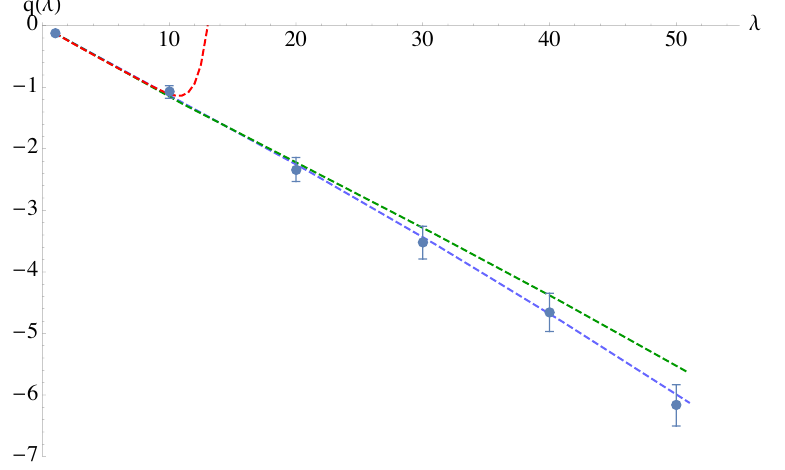
is the mean value of this empirical distribution.